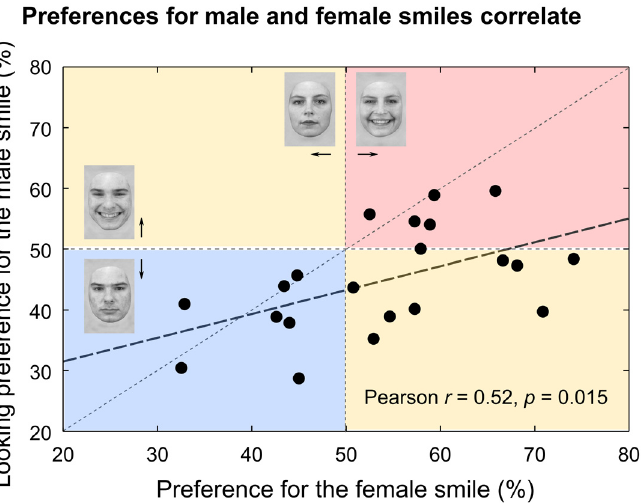
Fig 3. Individual looking preferences for male and female smiles correlate. Most infants showed a stronger preference for the smiling face on female face trials (i.e., smiling vs. neutral female face) than on male face trials (i.e., smiling vs. neutral male face), as is indicated by the position of the regression line below the identity line.